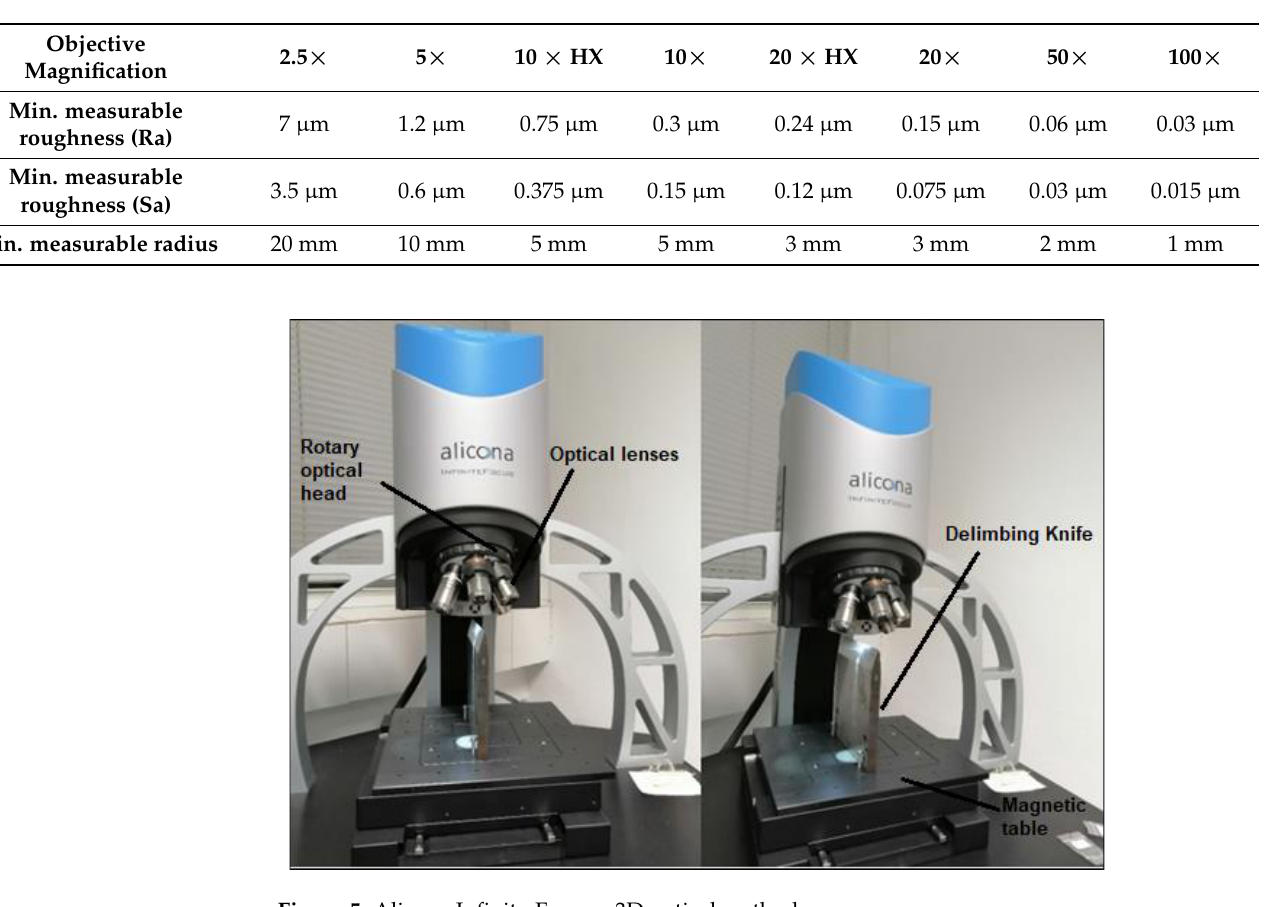
Table 2. Technical specification Alicona Infinite Focus .